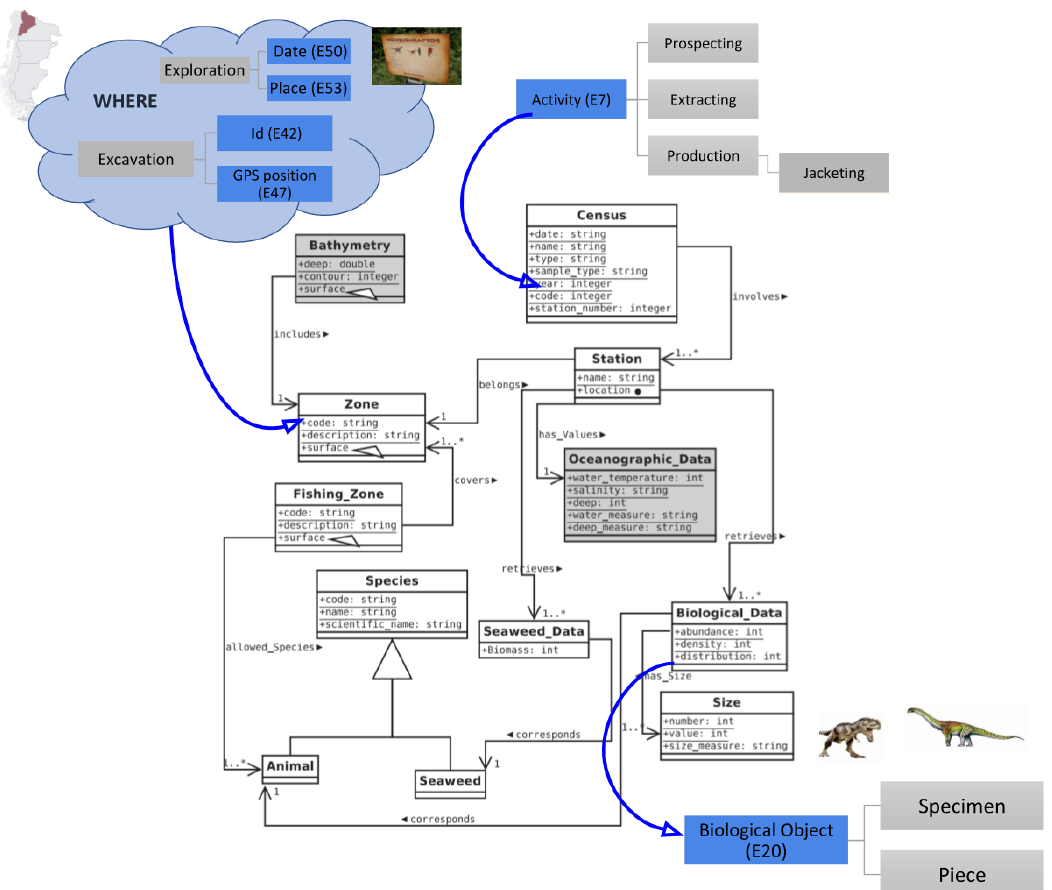
Figure 6. Mapping of the paleontology domain to other conceptual models.